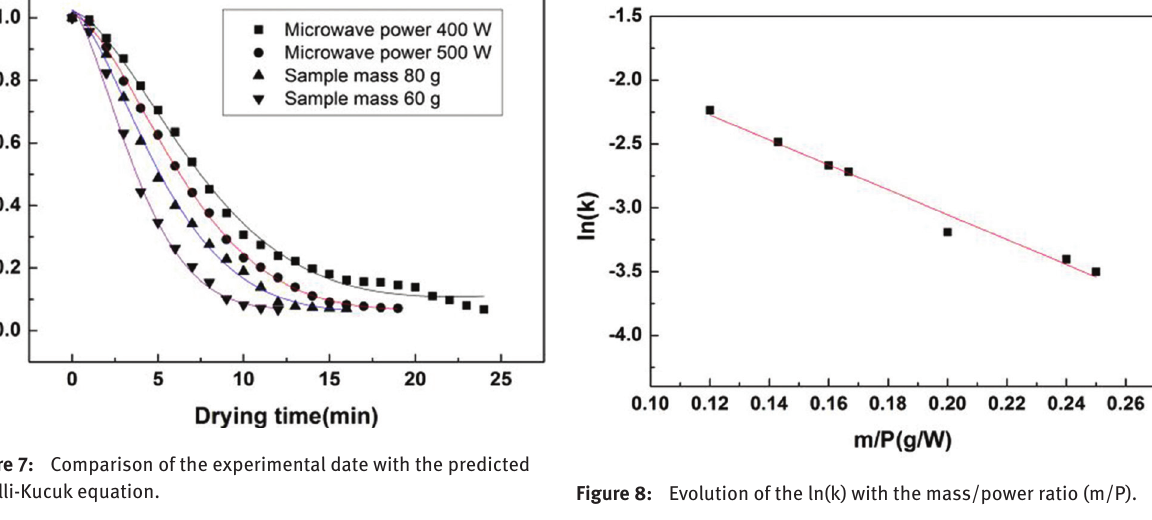
Figure 8: Evolution of the ln(k) with the mass/power ratio